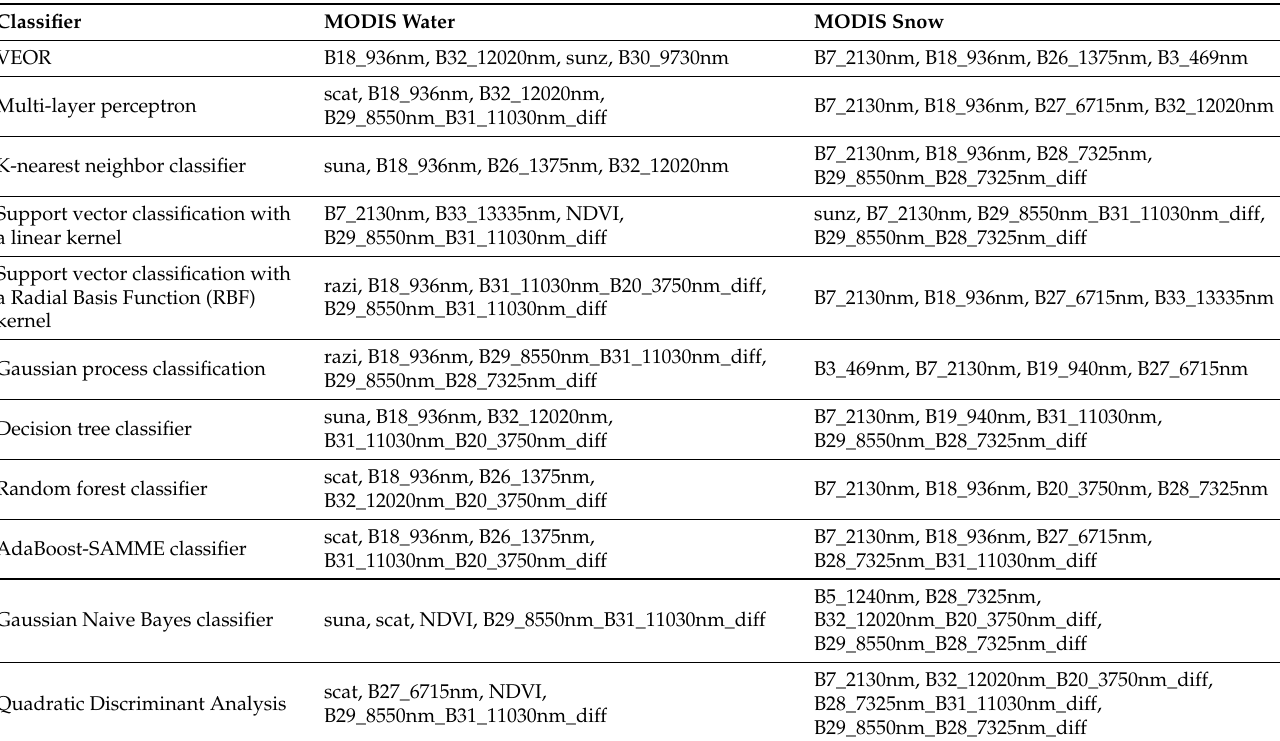
Table A1. Optimized features by means of a forward selection method for the experiments with MODIS cloud screening over water and